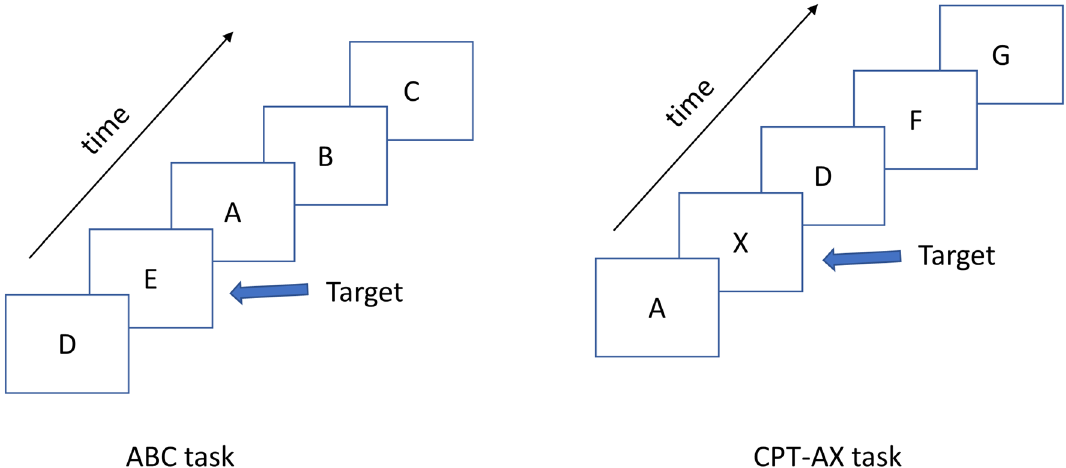
Figure 4. Typical sequence of letters presented in the ABC and CPT-AX tasks. In both tasks, images appeared on the screen for 300 ms and were followed by a blank screen with a duration of 1,500 ms. The ABC task presented a repeated sequence of the letters A, B, C, D, E with the requirement to press a microswitch on the appearance of the letter ‘E’. In the CPT-AX task, participants are required to press the microswitch on the appearance of the letter ‘X’ if it had been preceded by the letter